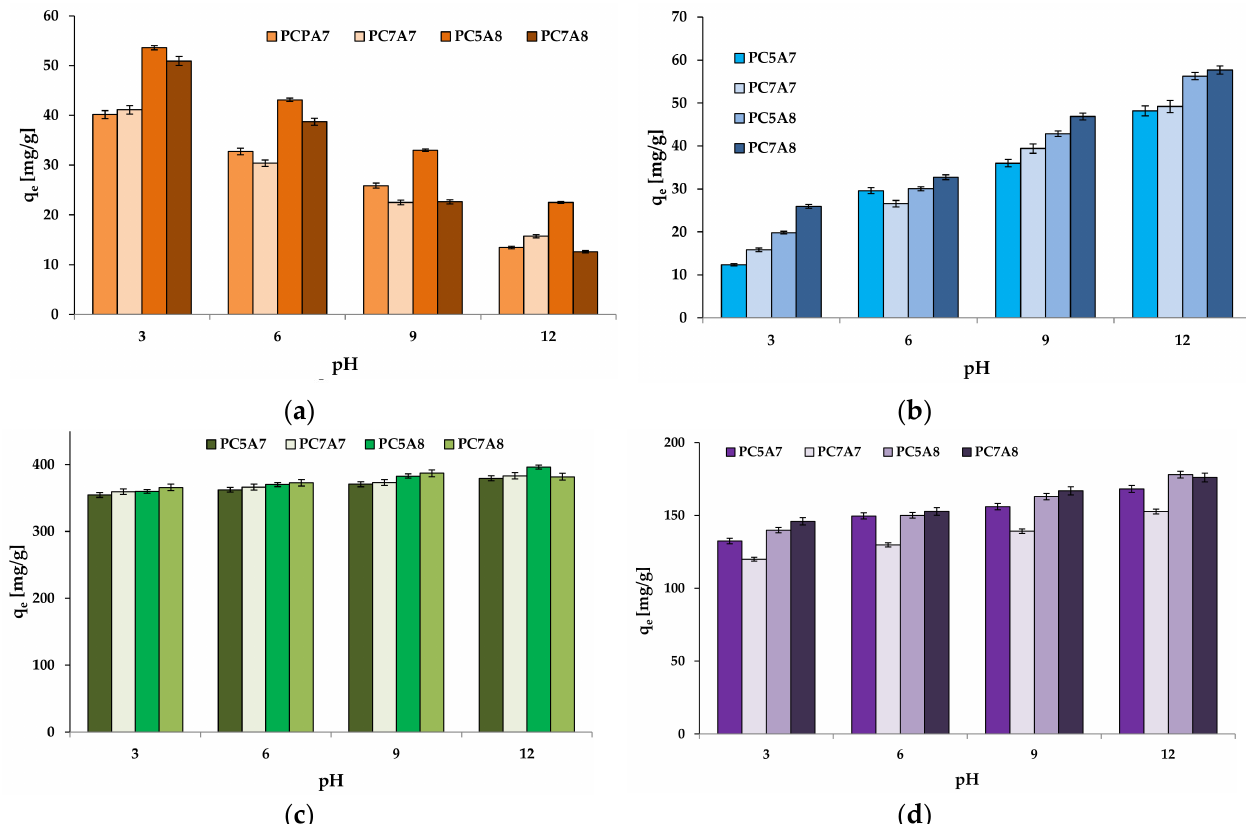
Figure 6. The effect of pH on the amount of organic dyes adsorbed on activated carbons: adsorbent mass = 25 mg, volume of solution = 50 mL, temperature =22 ± 2 °C, ( a ) methyl red 30 mg/L, ( b ) methylene blue 30 mg/L, ( c ) malachite green 200 mg/L and ( d ) crystal violet 90 mg/L).